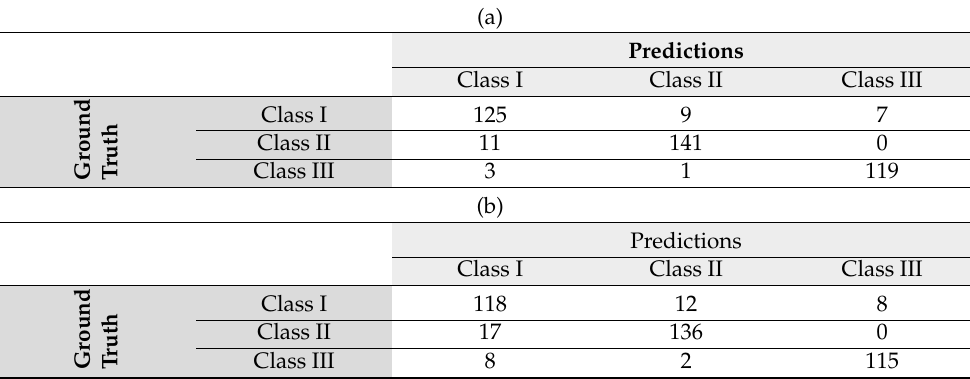
Figure 6. Test accuracies in five random sampling crossvalidations. Test 1: evaluation of the entire PA and lateral cephalometric images. Test 2: evaluation of the PA and lateral cephalometric images obscuring the mandible. Table 1. Confusion matrices of best accuracy results for (a) test 1 and (b) test